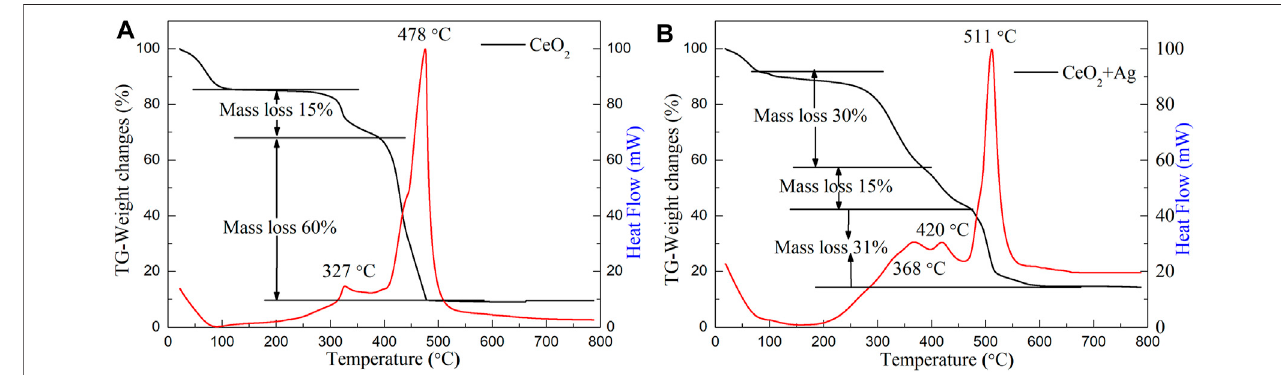
FIGURE 1 | Thermogravimetric analysis of (A) PVP/Ce (NO 3 ) 3 and (B) PVP/Ce (NO 3 ) 3 /AgNO 3 composite fi ber membranes with the Ag/CeO 2 molar ratios of 3:50 prepared by the electrospinning method.